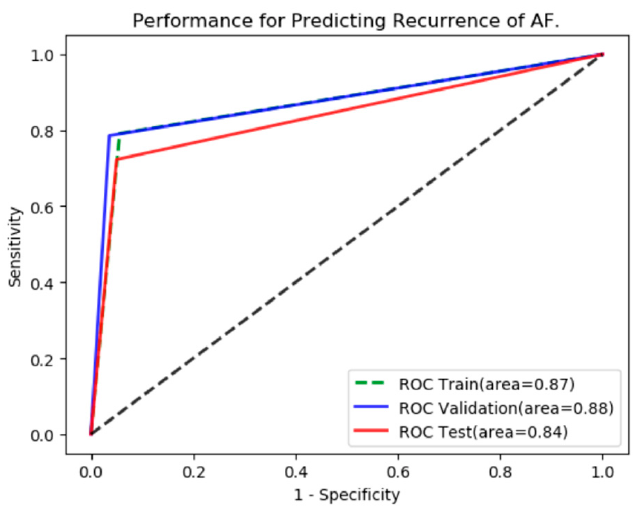
Figure 3. The Predictive Performance of AI Model. APPLE, BASE-AF2, CAAP-AF, DR-FLASH and MB-LATER scoring systems were used to predict the risk of recurrence, and the AUCs of each scoring system with dif- ferent cut-offs were shown (Figure 4A–E). The AUCs of APPLE were 0.51–0.56 (opti- mal 95% CI: 0.49–0.62, cut-off = 0.5), the AUCs of BASE-AF2 were 0.54–0.64 (optimal 95% CI: 0.58–0.70, cut-off = 0.5), the AUCs of CAAP-AF were 0.50–0.55 (optimal 95% CI: 0.49–0.60, cut-off = 4.5), the AUCs of DR-FLASH were 0.50–0.53 (optimal 95% CI: 0.46–0.59, cut-off = 1.5), and the AUCs of MB-LATER were 0.51–0.63 (optimal 95% CI: 0.57–0.69, cut-off = 1.5). The sensitivity, specificity, accuracy, precision and F1 score of the CNN model and the scoring systems with optimal AUC are shown in Table 2. Compared with each scoring system with optimal AUC, the predictive performance of the CNN model was significantly better (0.84 vs. 0.53–0.64, p < 0.01). Table 2. The Confusion Matrix of Different Score Systems. Predicted Se (%) Sp (%) Acc (%) Pre (%) F1 Scores p Value No R.